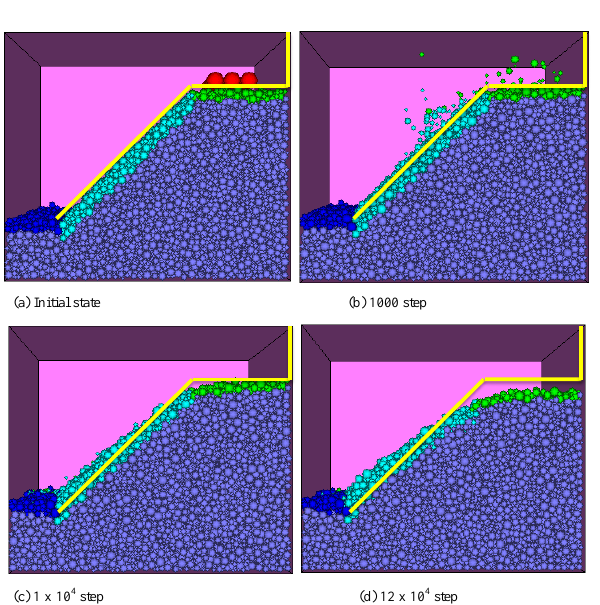
Figure 10 Failure process of numerical model under loading raft in XY direction Figure 10. Failure process of the numerical model under the loading raft in the xy direction.